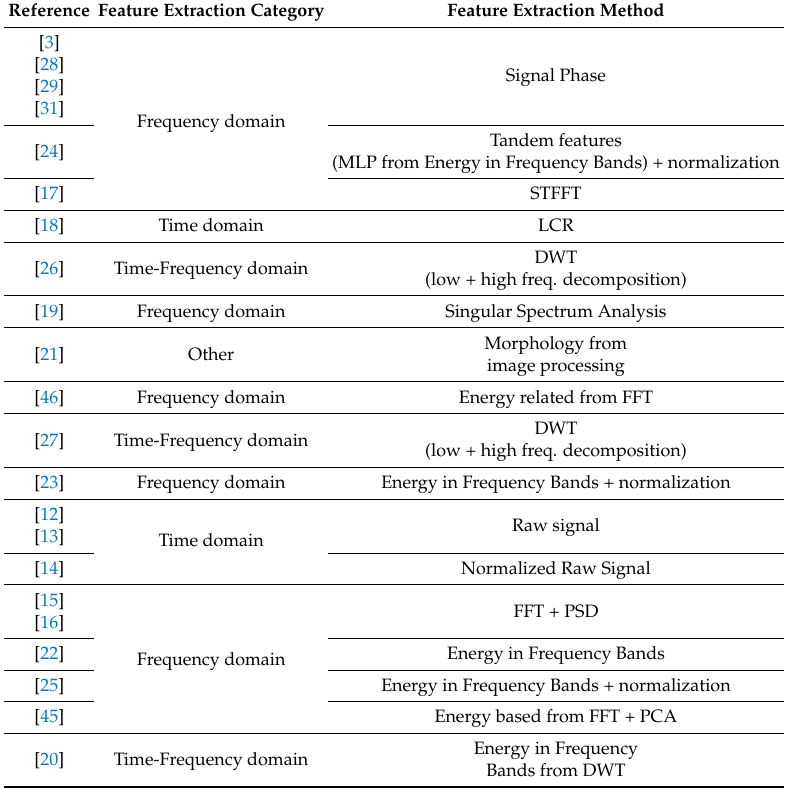
Table 7. Summary of the feature extraction (FE) approaches reported in the literature for DOFS+PRS. ‘LCR’ stands for level crossing rate, ‘MLP’ for multi-layer perceptron, ‘STFFT’ for short time fast Fourier transform, ‘PSD’ for power spectral density, ‘PCA’ for principal component analysis, ‘DWT’ for discrete wavelet transform, and ‘freq.’ for